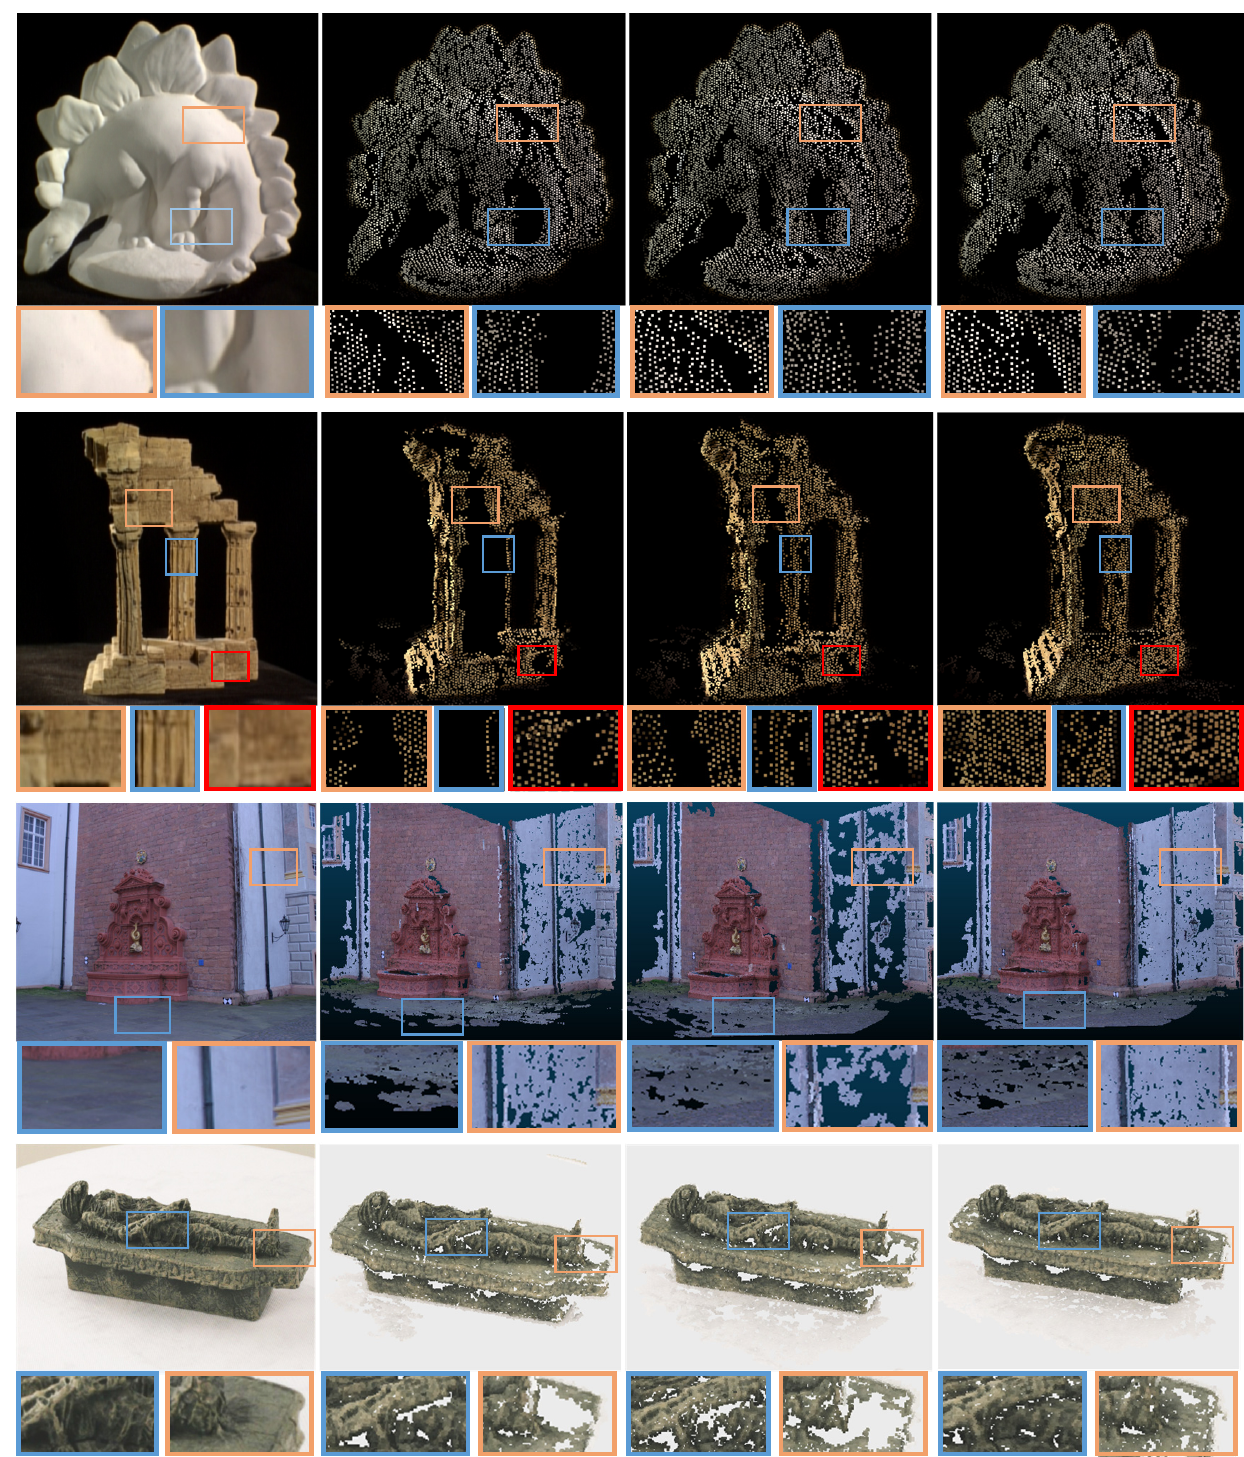
Figure 6. Comparison of three reconstruction methods on four testing datasets. From top to bottom: “Dino16”, “Temple16”, “Fountain25”, and “Mummy24”. From left to right: sample of image sequence, the results by PMVS, VisualSfM, and ours. The local details are highlighted and magnified into view. Ours generates reasonable dense points in textureless areas, e.g., the smooth back area of “Dino16”, the wall area of “Fountain25”, and the white platform of